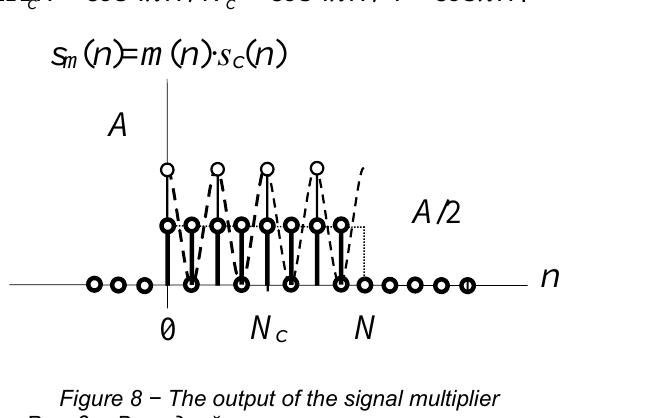
Figure 8 − The output of the signal multiplier Рис. 8 – Выходной сигнал умножителя сигнала Слика 8 – Излаз множача